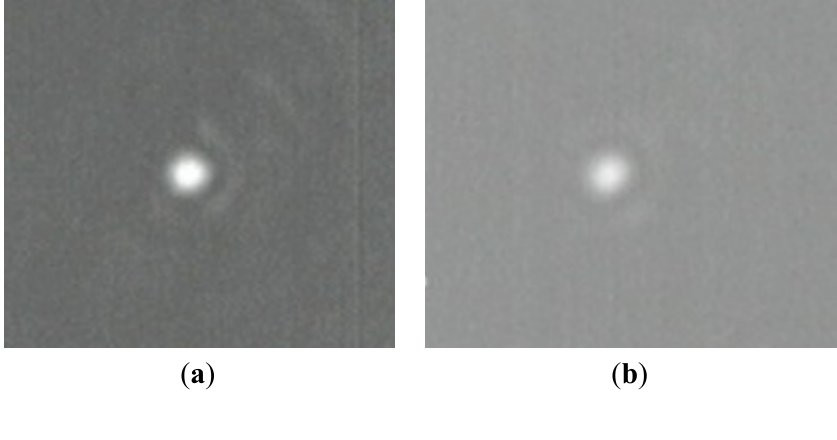
Figure 5. Near field observation of the Fiber 1 at: ( a ) 9.3 µm; and ( b ) 10.6